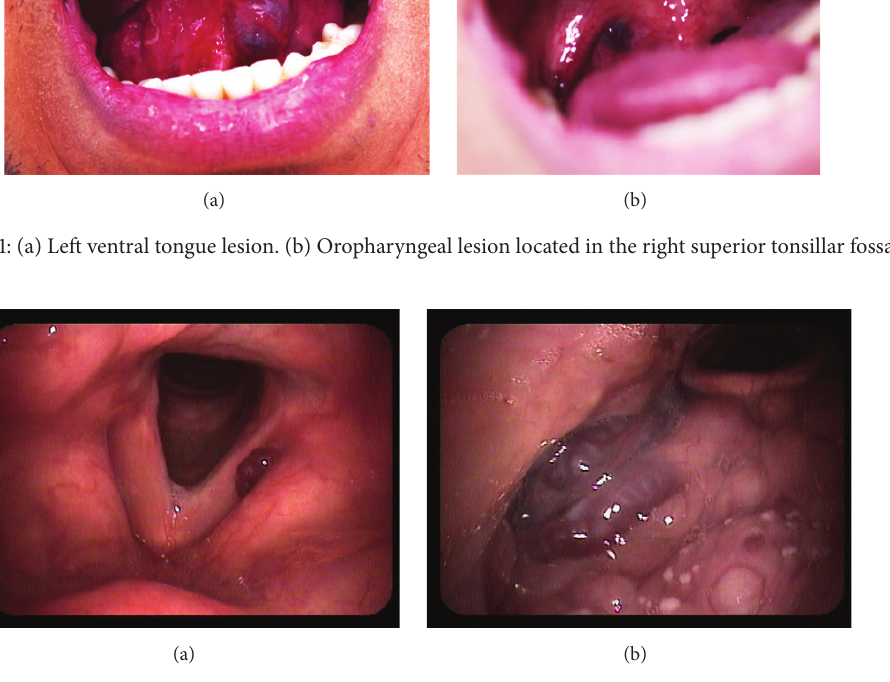
On physical exam, a 3 cm × 3 cm area mass was noted on the right side of the neck at level 2. The area was soft and nontender and had no associated skin changes. A thorough dermatological exam yielded no additional cutaneous